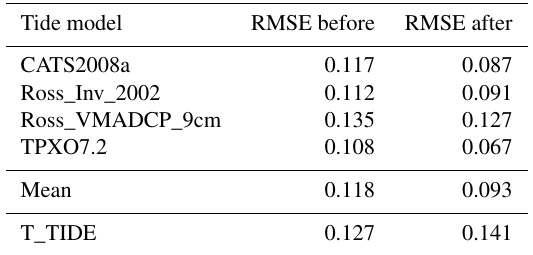
Table A1. Root-mean-square errors in metres between tide-model output and GPS data from Shirase before and after the adjustment to match